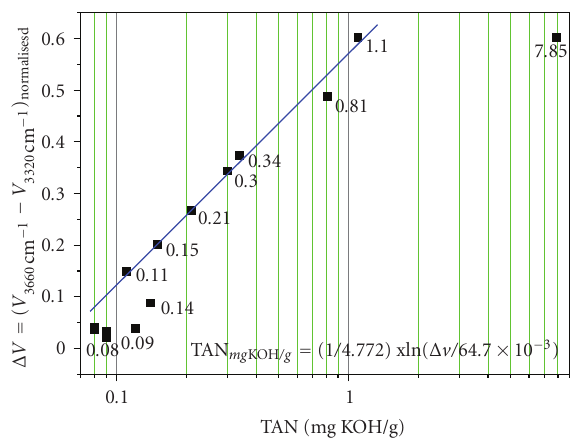
Figure 12: Acid sensitivity of the sensor system. The di ff erence in output signals of the 3660 cm − 1 and 3320 cm − 1 channels shows a logarithmic dependence on TAN in the range of 0 to 1mg KOH/g.